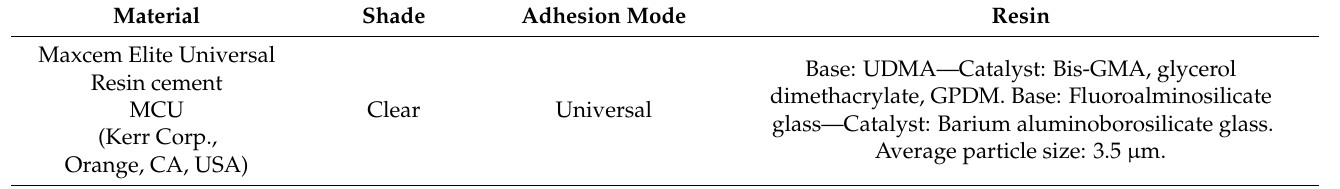
Table 1. Information of the resin cements investigated according to